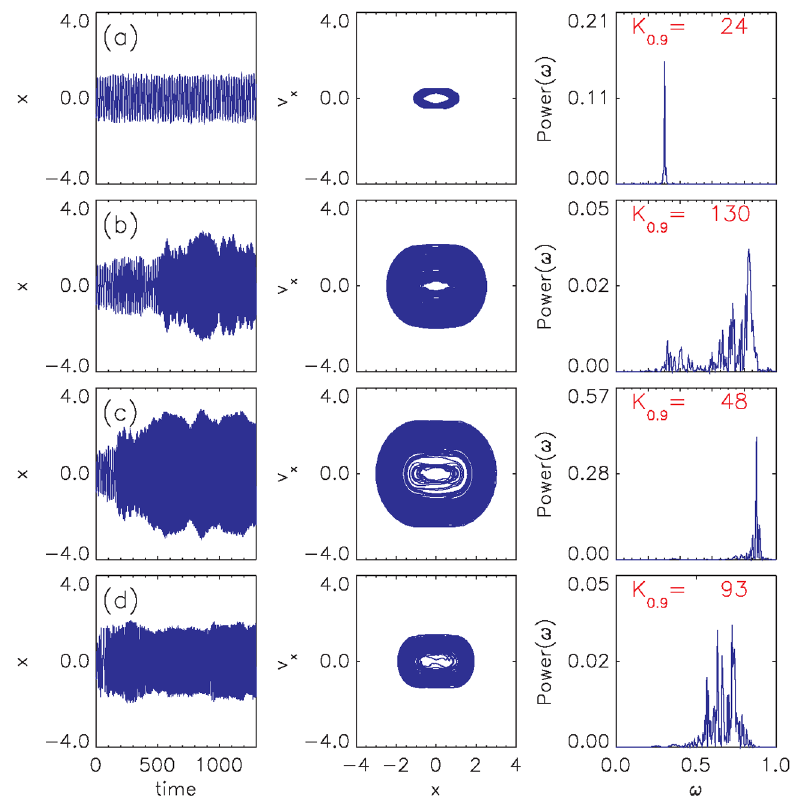
FIG. 1. (Color) Plots of an example orbit having initial conditions x (cid:6) 0 (cid:7) (cid:2) (cid:4) 0 : 733 407 , _ x (cid:2) 0 , in the presence of various noise (cid:2) 0 : 1 , (cid:13) (cid:2) 0 , t (cid:2) 80 . The orbit is plotted in configuration space x vs t (left panel) and in phase space _ x vs x strengths with (cid:13) c 1 2 (center panel), along with its corresponding power spectrum (right panel) wherein the complexity K orbital chaoticity (see Sec. III A). The four rows correspond to different noise strengths: (a) hj (cid:22)! ji (cid:2) 0 , (b) hj (cid:22)! ji (cid:2) 0 : 001 , (c) hj (cid:22)! ji (cid:2) 0 : 01 , and (d) hj (cid:22)! ji (cid:2) 0 : 1